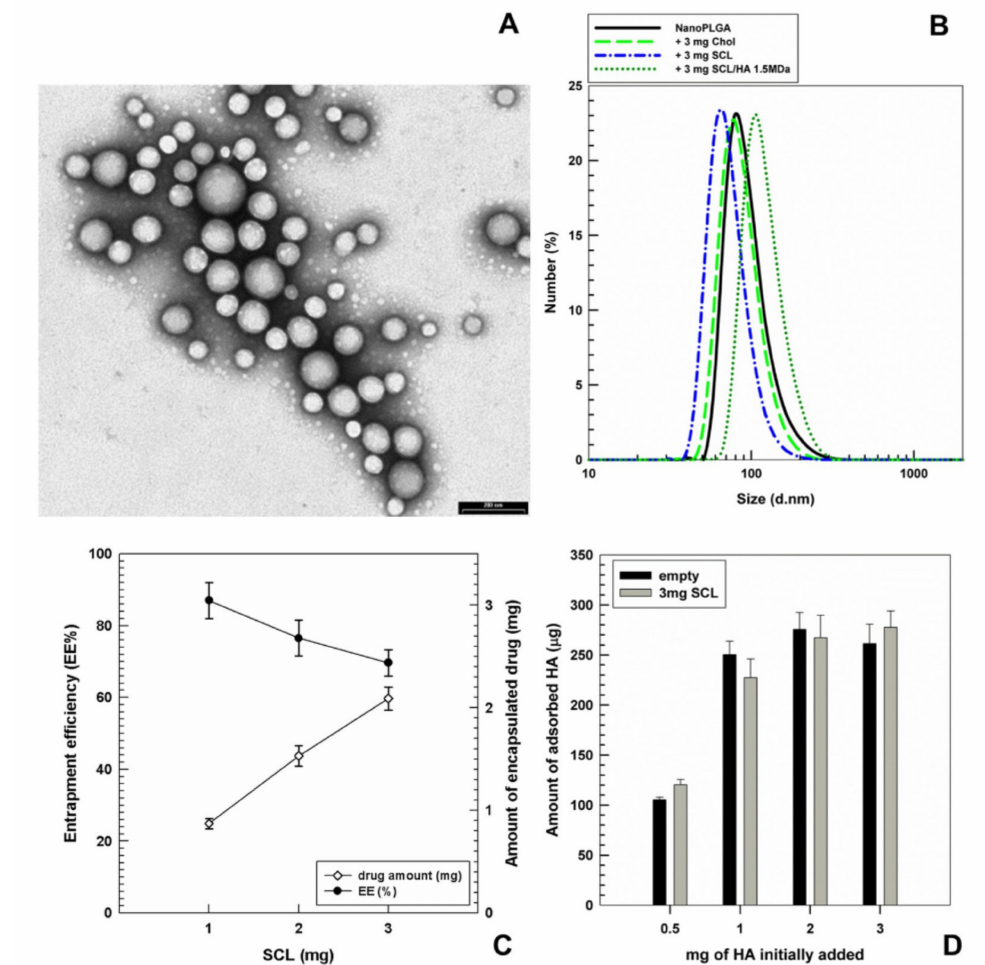
Figure 3. ( A ) TEM micrograph of PLGA nanoparticles prepared by using 3 mg of sclareol (SCL); bar = 200 nm. ( B ) Mean sizes of PLGA nanoparticles prepared by using 3 mg of cholesterol